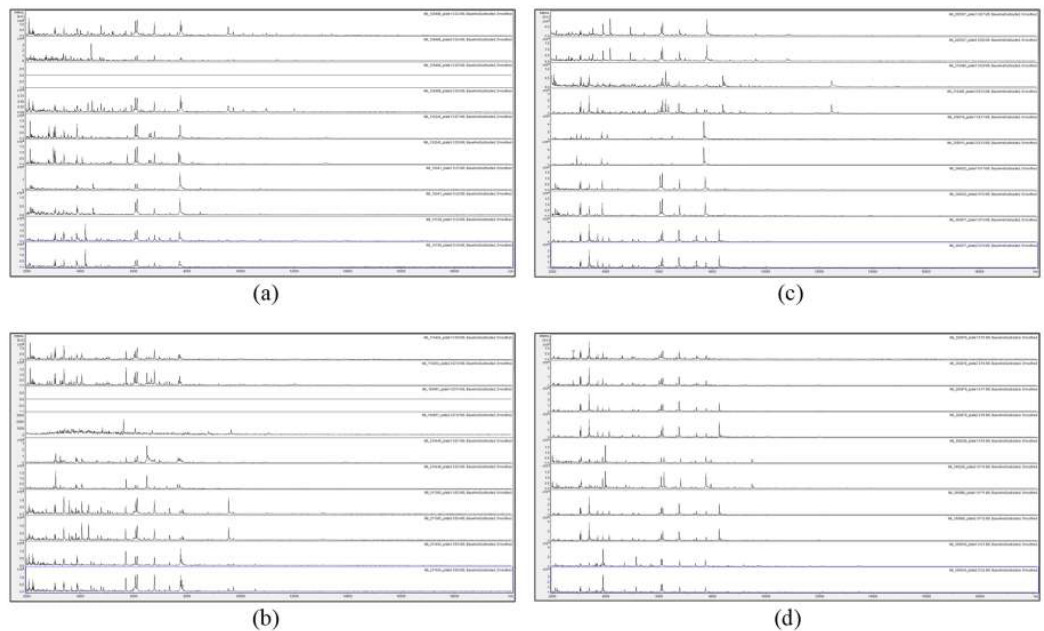
Figure 1. Matrix-assisted laser-desorption and ionization time-of-flight mass spectrometry (MALDI-TOF MS) spectra of acid-soluble fungal proteins from duplicate plates (plate 1 above and plate 2 below), for ( a ) from top to bottom IMI 129488, IMI 129489, IMI 133245, IMI 16041 ii, and IMI 16139; ( b ) from top to bottom IMI 174454, IMI 194967, IMI 210448, IMI 211385, and IMI 211400; ( c ) from top to bottom IMI 226507, IMI 314386, IMI 339610, IMI 349032, and IMI 360877; and ( d ) from top to bottom IMI 360878, IMI 360879, IMI 366228, IMI 360880, and IMI 369918. IMI: Imperial Mycological Institute.